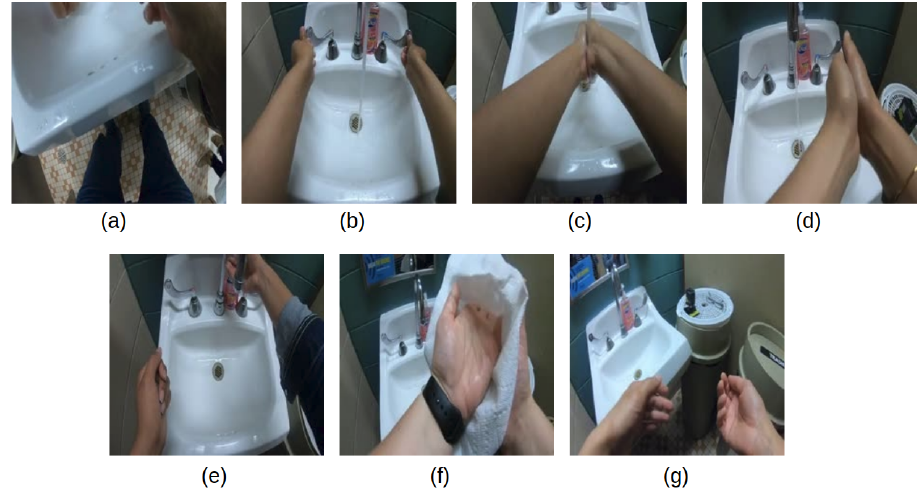
Figure 4. ( a ) Touch faucet with elbow, ( b ) touch faucet with hand, ( c ) rub hands with water, ( d ) rub hands without water, ( e ) apply soap, ( f ) dry hands with towel, ( g ) non-hand-hygiene